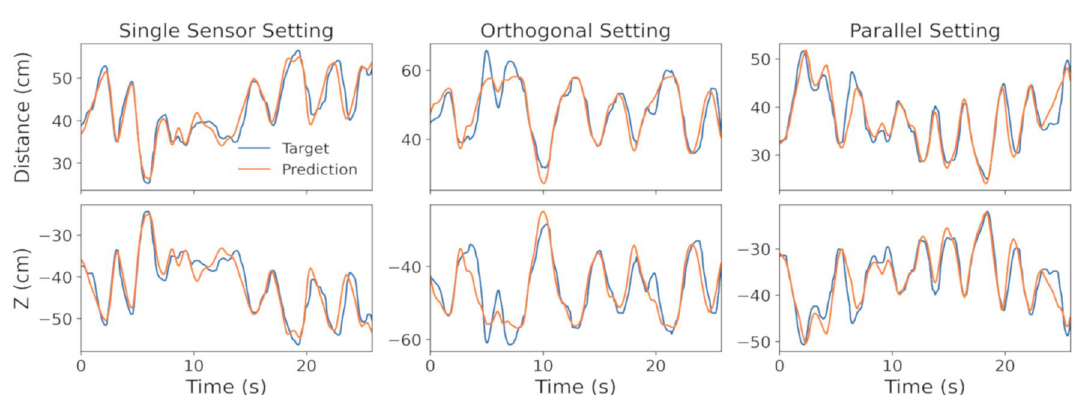
Figure 4. Measurement versus estimation. The measured ground-truth and estimated distance and Z-direction displacement of MI sensors relative to the central node over